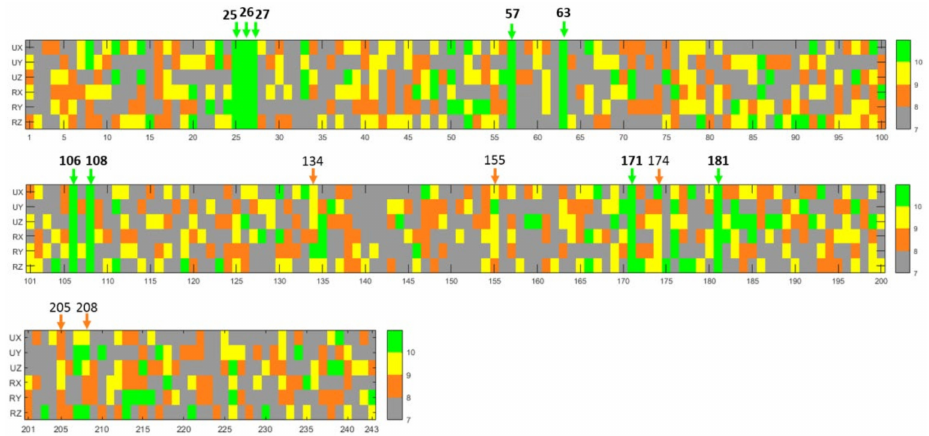
Figure 12. Data frequency graph in the 10 best performance networks for T1. Most used 14 input data are